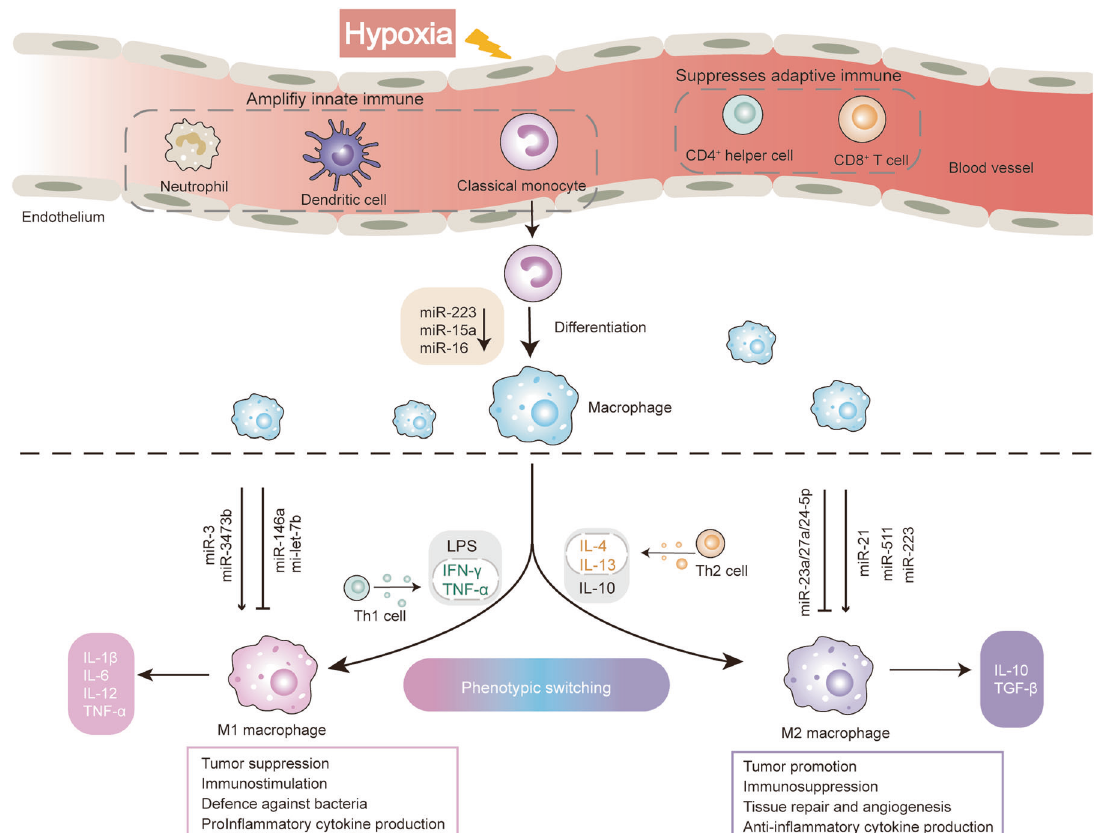
Fig. 2 The regulation of miRNA to macrophage polarization. Hypoxia suppresses the adaptive immune system response, and ampli fi es the activity of innate immune cells, partly by negatively regulating the polarization of CD4 + helper T cells to prevent over-activation of the immune host defense system. Macrophages are formed through the differentiation of monocytes and could be divided schematically into two main classes: M1 and M2. Monocytes mature to M1 macrophages induced by IFN- γ , TNF- α , and LPS, which secrete pro-in fl ammatory cytokines, such as TNF- α , IL-1 β , IL-6, IL-12. They are characterized by the cytotoxic activity against bacteria and tumor cell, which usually strengthens in fl ammation. M2 macrophages polarization induced by IL-4, IL-13, and IL-10, which usually shut down destructive immune system activation by producing anti-in fl ammatory cytokines IL-10 and TGF- β . M2 macrophages participate in wane in fl ammation, scavenge debris and tumor promotion and restore tissue repair. In the process of human monocyte-macrophage differentiation, the expression of miR-223, miR-15a, and miR-16 is signi fi cantly decreased, which can promote the polarization of M1 macrophages. MiRNAs expressed at different levels in response to environmental stimuli can participate in the polarization of macrophages to M1 or M2 phenotypes, which can promote or inhibit the polarization,